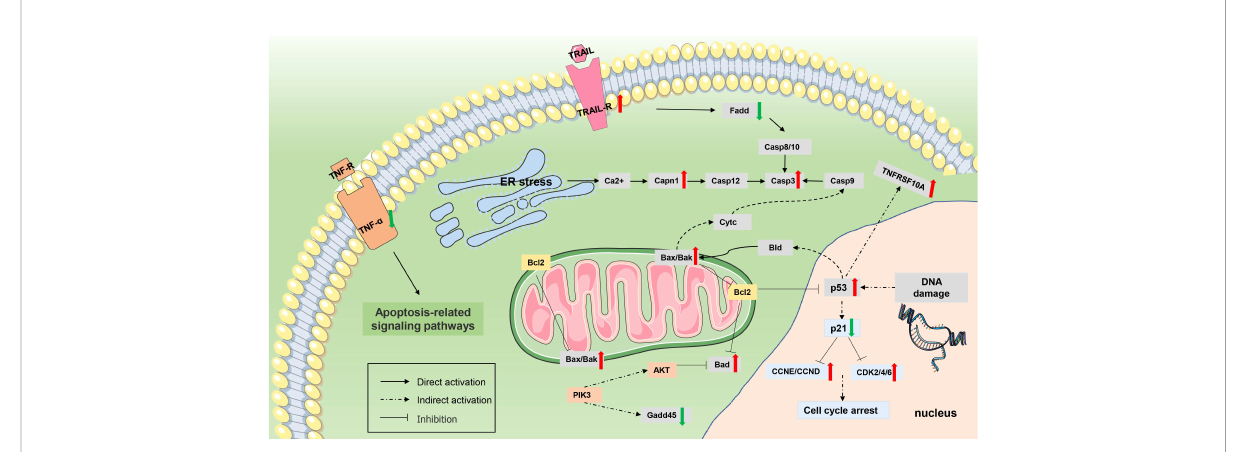
FIGURE 11 Differentially expressed genes (DEGs) involved in apoptosis. The genes whose expression was up-regulated (P value <0.05 and |log2(fold change) ≥ 1) are highlighted in red, and whose expression was down-regulated (P value <0.05 and |log2(fold change) ≥ 1) are highlighted in